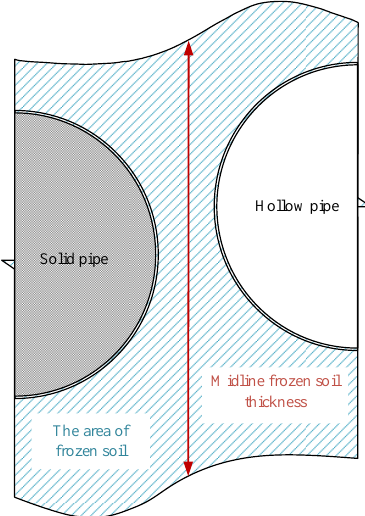
Buildings 2022 , 12 , x FOR PEER REVIEW 12 of 19 Figure 5. Evaluation index. Figure 5. Evaluation index.